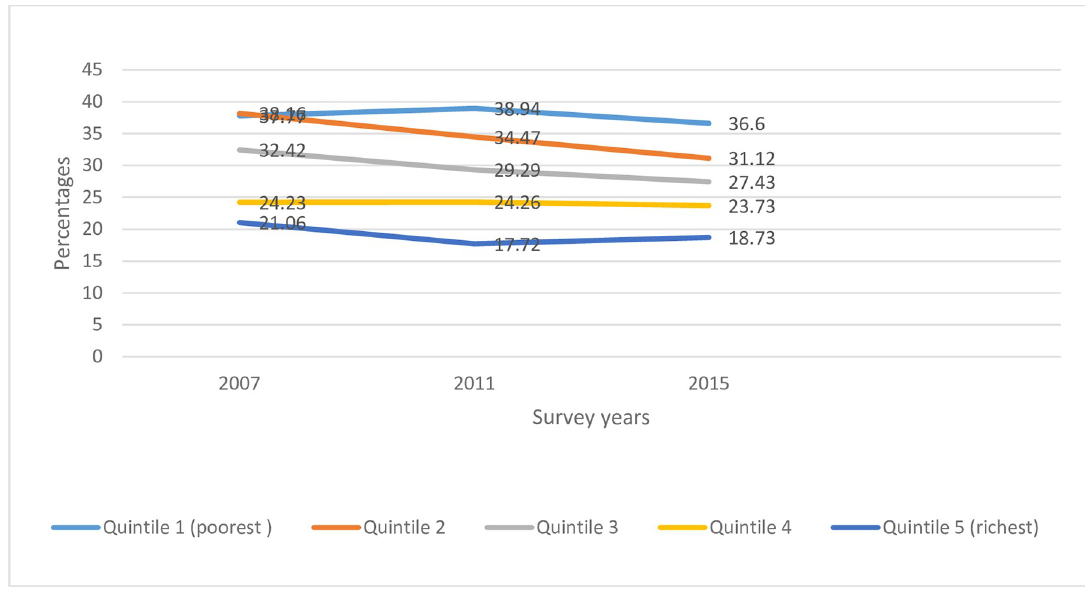
Fig 1. Trends in the prevalence of childhood stunting across the wealth quintiles in Mauritania, MICS (2007–2015).